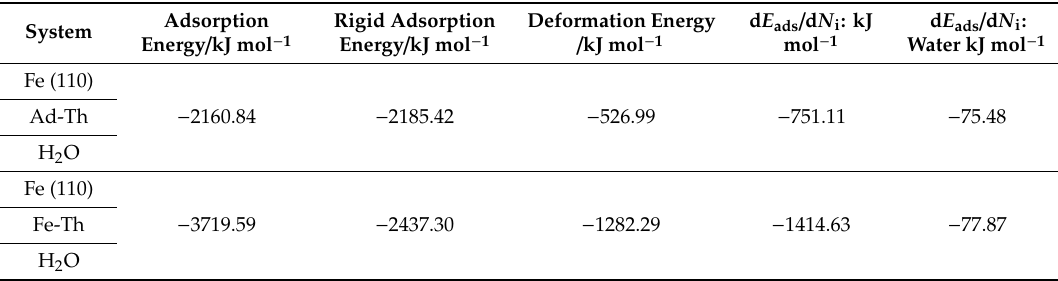
Table 4. Selected energy indices acquired from MC simulations for the adsorption of Ad-Th and Fe-Th molecules on Fe (110) surface.